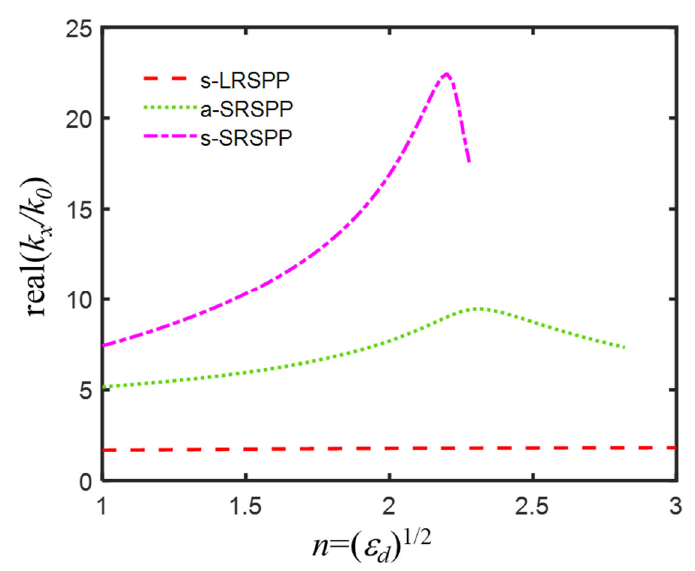
n k k  of s-LRSPP, a-SRSPP, and s-SRSPP of √ 0 eff x ε d of central dielectric layer from 1 to 3 with an  of central dielectric layer from 1 to 3 with an d